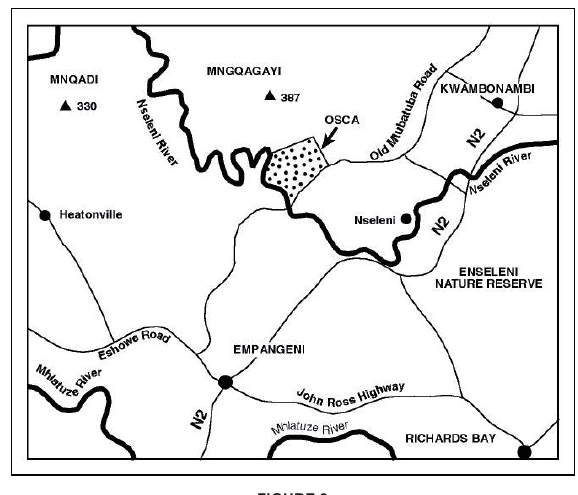
Figure 2 Locality of the Owen Sitole College of Agriculture in Zululand,